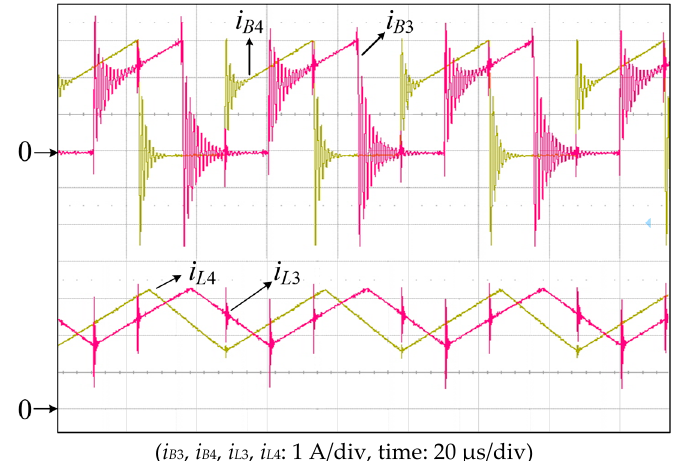
Figure 8. Battery and inductor currents during the detection stage.